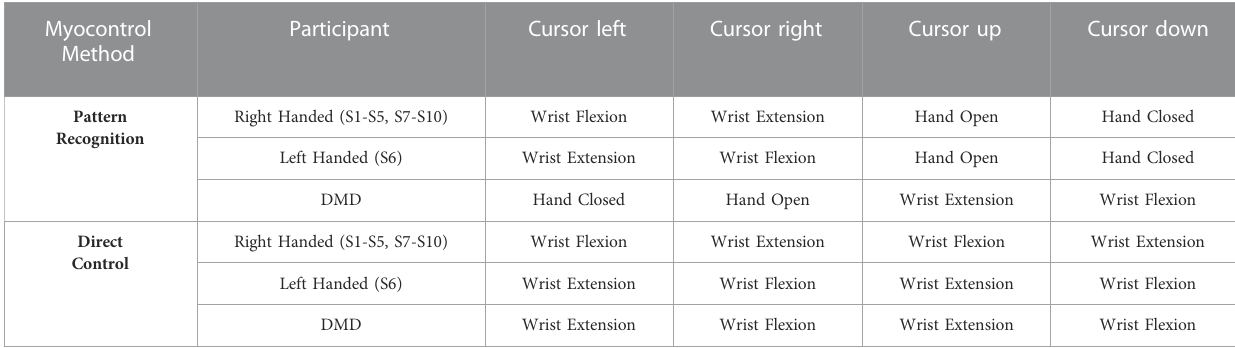
TABLE 1 Mapping of limb motion to cursor motion during PR and DC